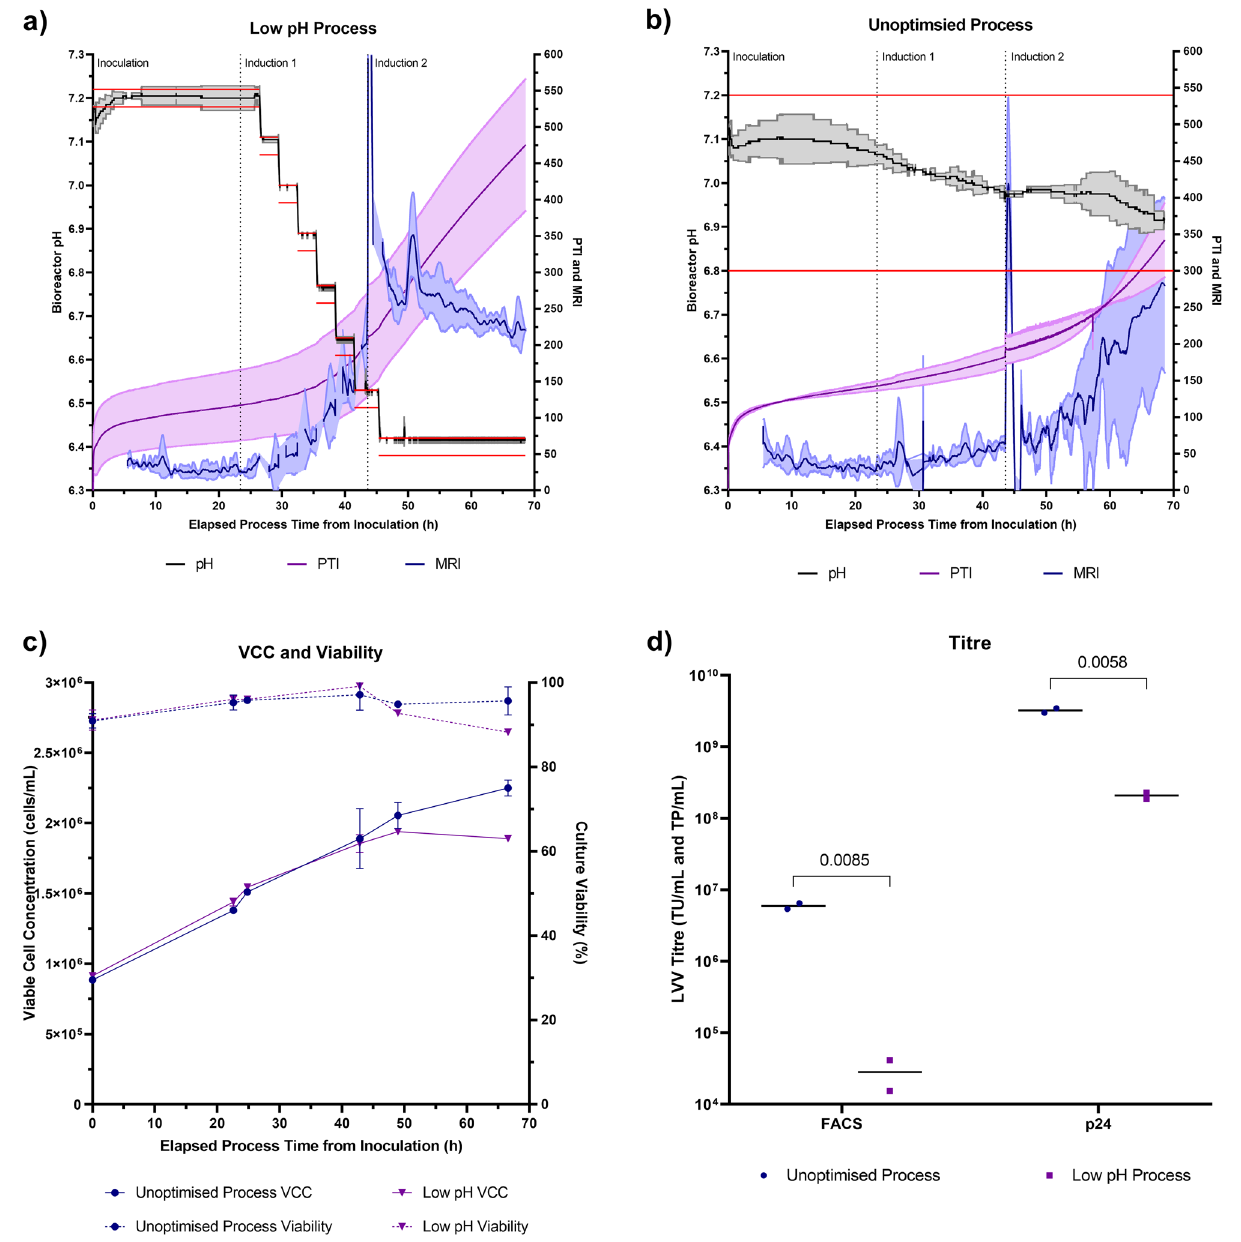
Figure 4. Performance comparison of the ‘low pH’ and ‘unoptimised’ HIV-1-GFP LVV production bioprocesses. PTI, MRI and pH traces obtained when employing the ( a ) ‘Low pH’ control strategy in two replicate bioreactors and when employing the ( b ) ‘Unoptimised’ pH control strategy in two replicate bioreactors. Black, dark purple and dark blue traces indicate the mean of replicate bioreactor processes and grey, light purple and light blue traces indicate ± 1 standard deviation of the mean. Horizontal red lines indicate pH dead-band and vertical dashed black lines indicate key process events. ( c ) VCC and culture viability data obtained from bioreactors employing the two pH control strategies. Data points represent the mean for duplicate bioreactors and errors bars are ± 1 standard deviation of the mean. ( d ) Functional LVV titres and total LVV particles obtained via the two